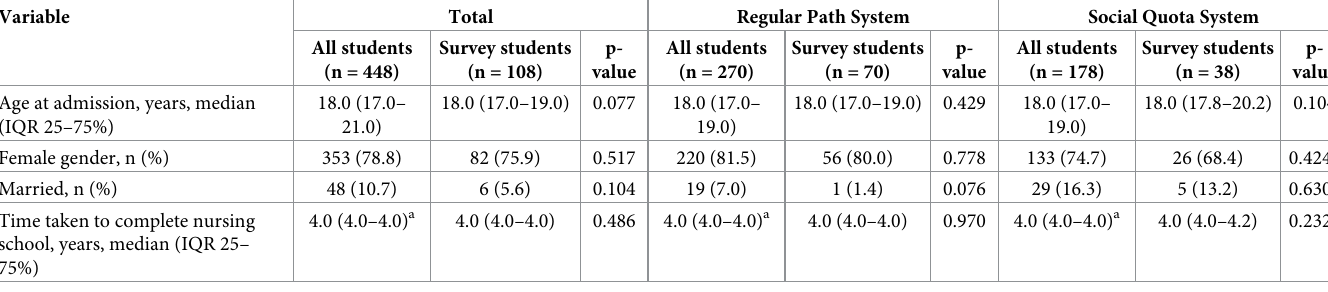
IQR, interquartile range; SD, standard deviation.